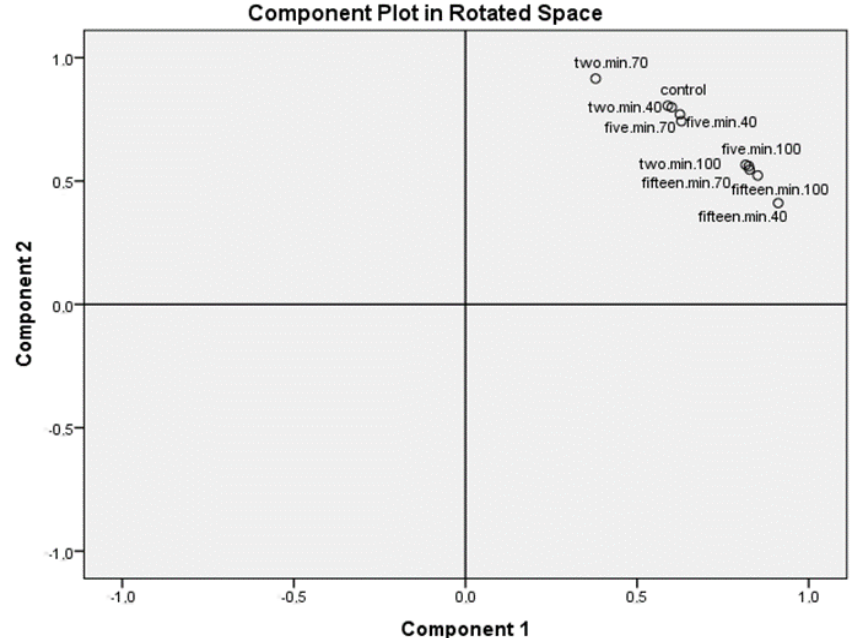
Figure 1. Principal component analysis for all analyses obtained for analyzed samples.